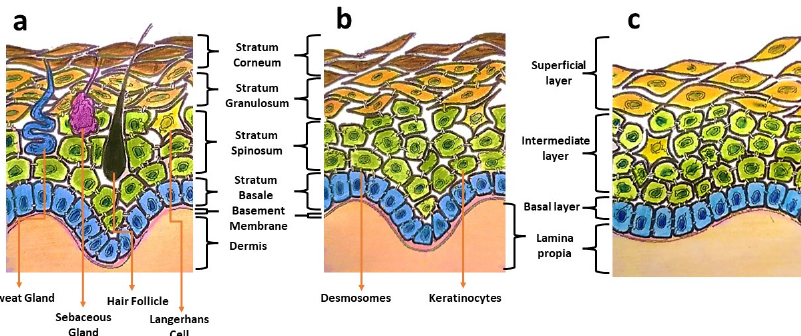
Figure 1. Illustrations showing differences in the components of skin ( a ), keratinized masticatory oral mucosa ( b ), and non-keratinized oral mucosal lining ( c ).